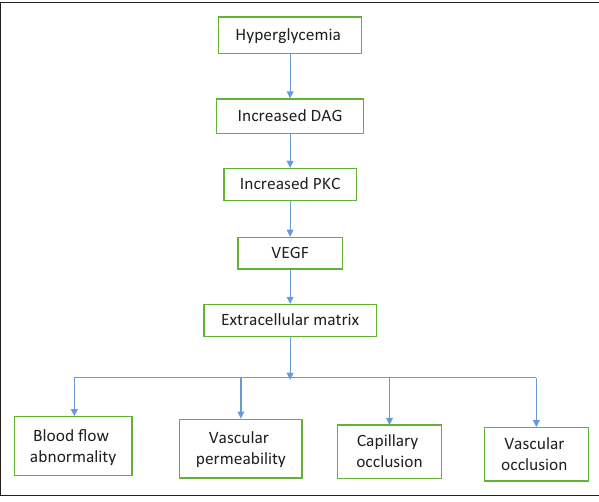
FIGURE 2: The protein kinase C pathway. Chronic hyperglycaemia increases quantity of diacylglycerol (DAG) which leads to activation of protein kinase C (PKC). The PKC activation leads to increased vascular permeability and upregulation of vascular endothelial growth factors in the retinal structure. This may lead to increased activation of leukostasis and significant changes in extracellular matrix protein synthesis. Eventually, DAG and PKC pathways adversely affect inflammation, neovascularisation and retinal haemodynamics which lead to progression of diabetic